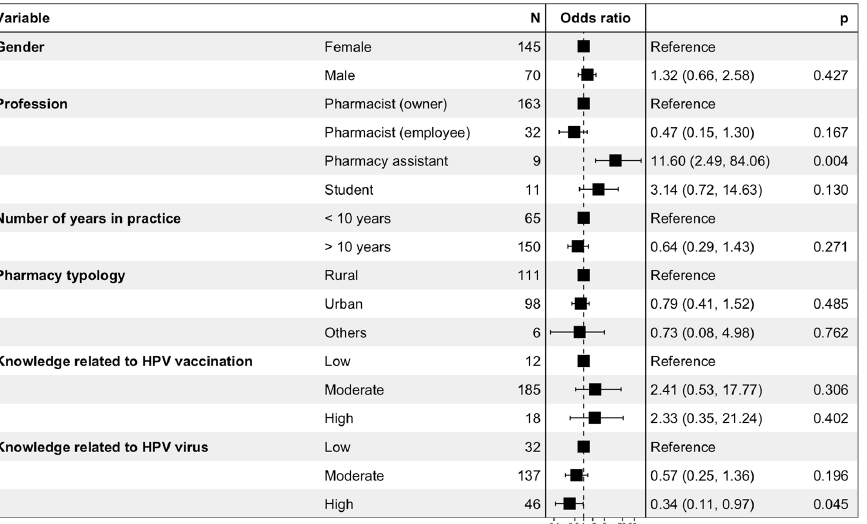
Figure 9. Binary logistic regression performed to evaluate the determinants of